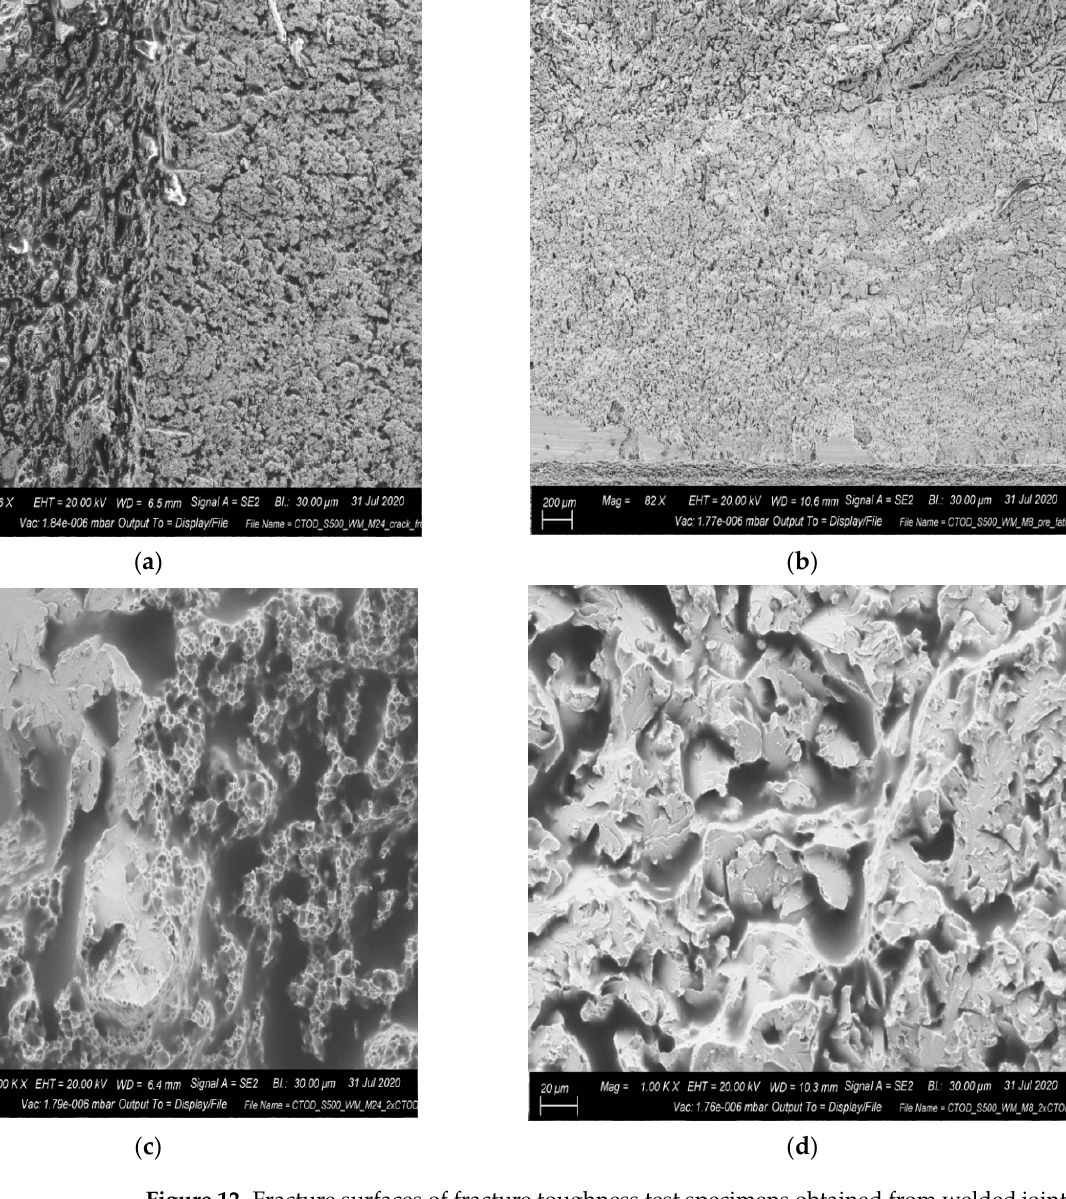
Figure 12. Fracture surfaces of fracture toughness test specimens obtained from welded joints with the front of fatigue pre-crack ( a ) after mainly ductile failure; and ( b ) after brittle failure; magnification of the fracture failure zones in the middle of the specimen with ( c ) clearly visible dimples (ductile failure); and ( d ) purely transgranular cleavage fracture.